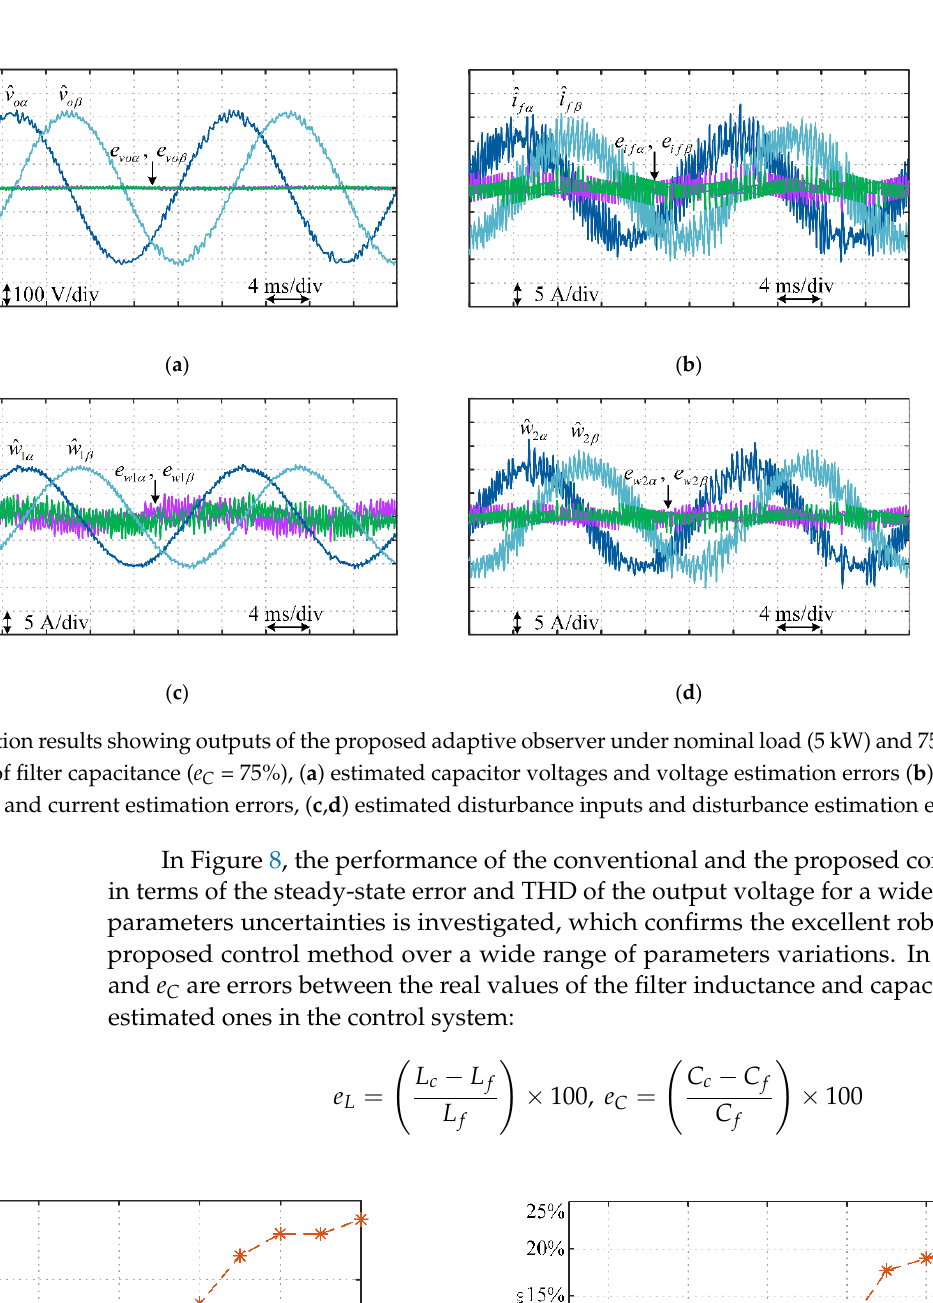
Figure 6. Simulation results showing steady-state performance under nominal load (5 kW) and 75% error in the initial value of filter capacitance ( e C = 75%), ( a ) the proposed adaptive MPC, ( b ) conventional MPC.